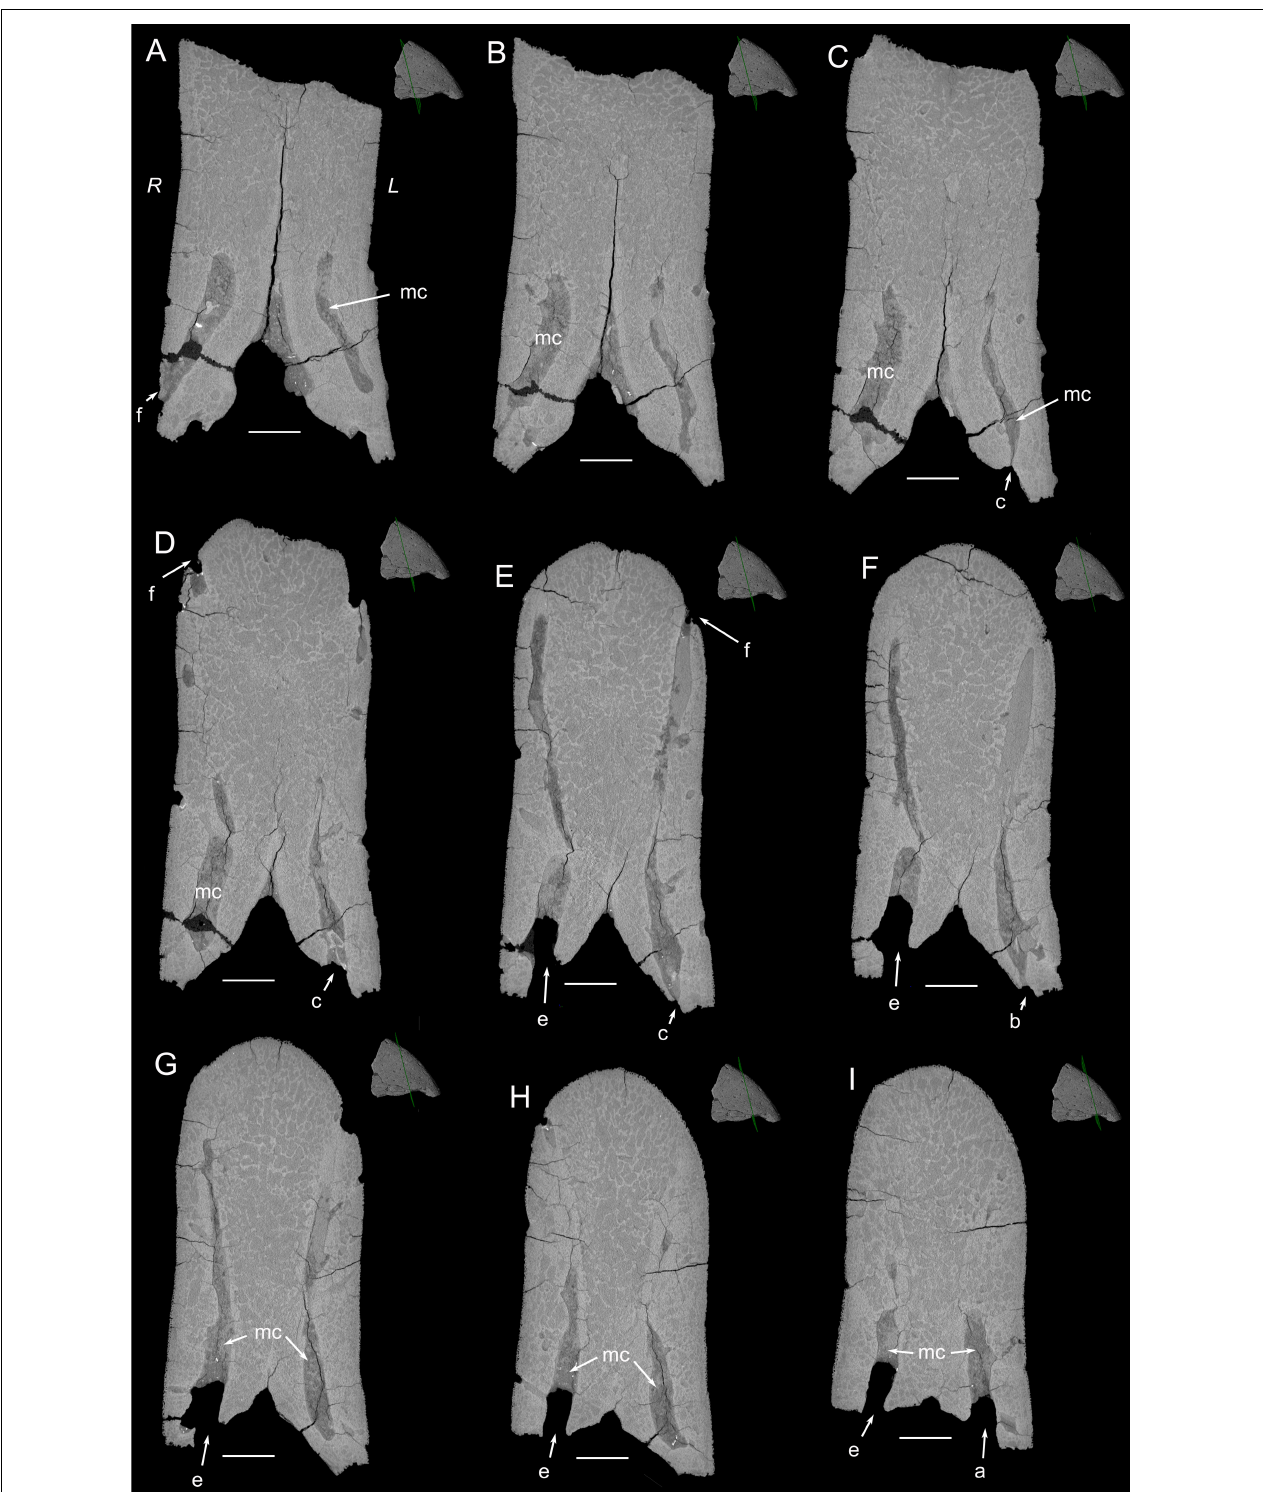
FIGURE 3 | Nine parallel transverse sections through the premaxilla of YPM 13106. The planes of section are shown on the upper right corner of each virtual section. (A–I) The sections proceed from more caudal to more rostral. R, right side of a section. L, left side of a section. The succession of section planes (separated by ca. 2.2 mm) reveal connections between the large ventral openings (here a, b, c, e; see Figure 1 ), the medullary cavity (mc) and vascular canal openings, or foramina (f) to the dorsal and lateral sides of the premaxilla. Scale bars, 5 mm.